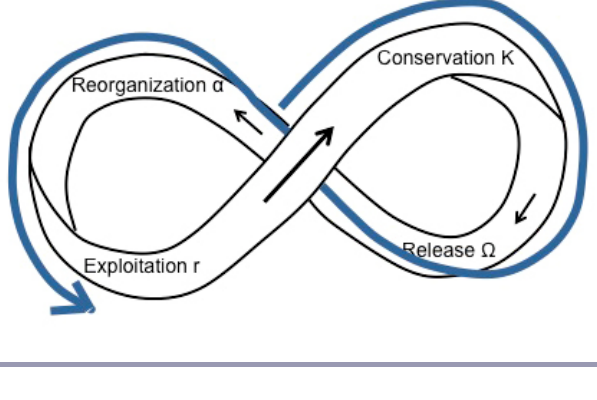
Fig. 5 . Overlay of politicians’ narrative onto the adaptive cycle. The politicians’ narrative aligned with the very early r phase: the SES had collapsed from an agricultural landscape in the mid-1990s (collapse from K), had been reorganizing between the late 1990s and the late 2000s (moving through Ω and α ), and was currently a multifunctional landscape. SES indicates social- ecological system.